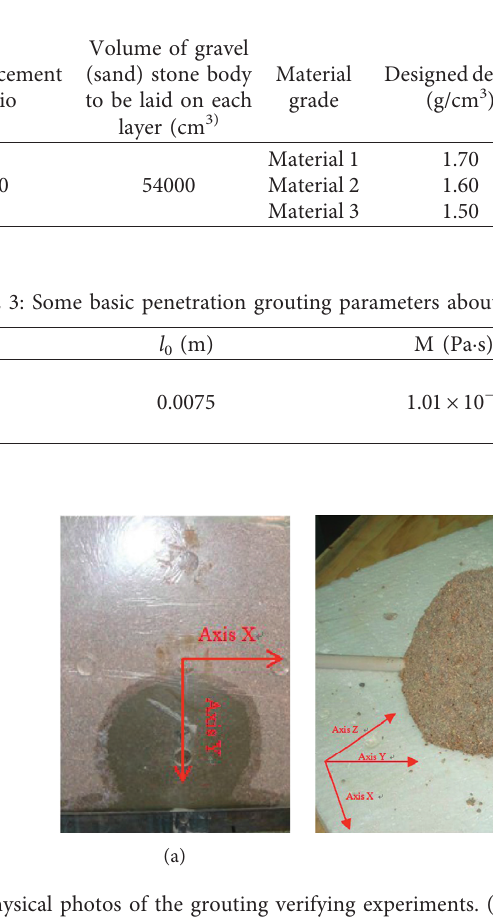
Table 2: Design parameters of grouting experiments.